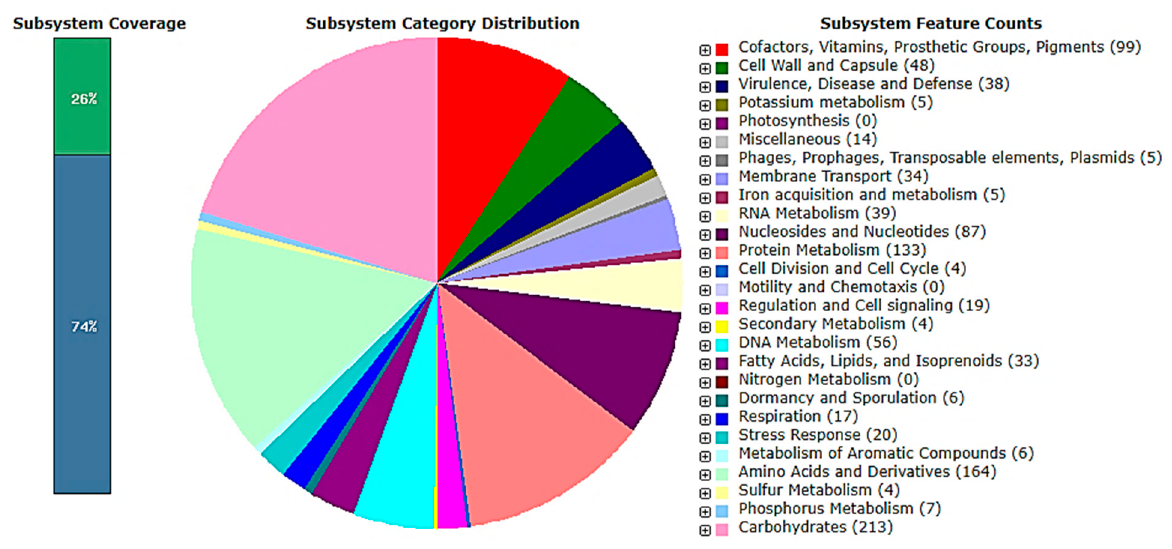
Figure 2. Subsystem coverage and distribution of L. plantarum 13 ‐ 3 genome by RAST. The KEGG pathways of entire genome for the blend of fundamental biomolecules and optional metabolites particularly exopolysaccharides (EPS) are displayed in Figure 3.